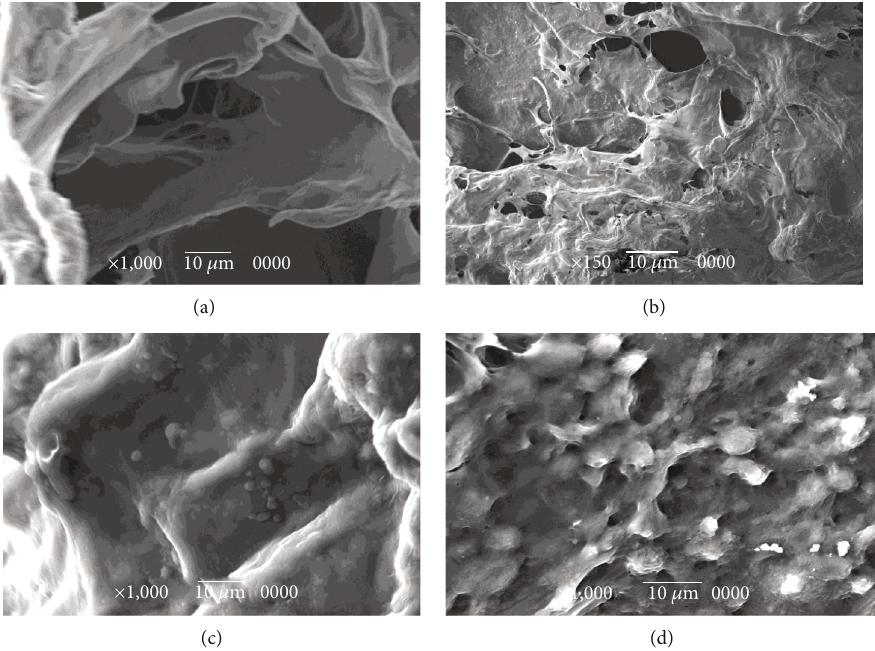
Figure 10: (a, b) Derm-skin sca ff old with collagen sheet, without chondrocytes at SEM magni fi cation × 1,000 (a) and magni fi cation × 150 (b). (c, d) The SEM shows the presence of well-integrated chondrocytes at 15-21 days, magni fi cation × 1,000. The chondrocytes were able to construct and modify the sca ff old